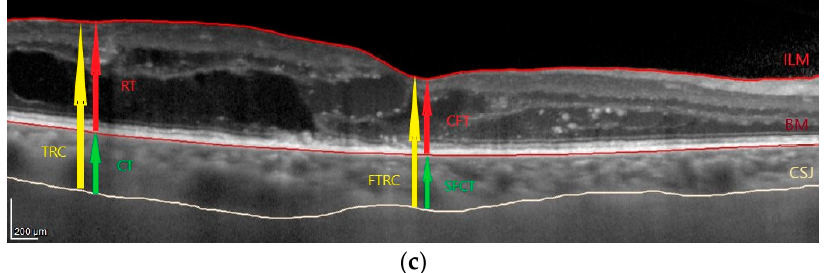
Figure 1. Representative OCT scans across the fovea representing measurements and types of diabetic macular oedema (DME): ( a ) control; ( b ) cystoid; ( c ) diffuse. DME with subretinal fluid was classified as such regardless of concomitant cystoid or diffuse oedema. In cases of mixed cystoid and diffuse oedema, the eye was classified according to the predominant type. As described previously [37], internal limiting membrane (ILM) and Bruch’s membrane (BM) were detected automatically, while the choroidal-scleral junction (CSJ) was marked manually. Subfoveal choroidal thickness (SFCT) was defined as the distance between the BM and the CSJ at the fovea (green arrow). The SFCT was manually measured using the calliper tool and calculated as the difference between the foveal total thickness (FTRC, retinal + choroidal thickness, from the ILM to the CSJ; yellow arrow) and the central foveal thickness (CFT; red arrow). Analogically, the choroidal thickness outside the fovea (CT; green arrow) was calculated by subtracting the retinal thickness (RT; red arrow) from the total thickness (TRC, retinal + choroidal thickness, from the ILM to the CSJ, yellow arrow).